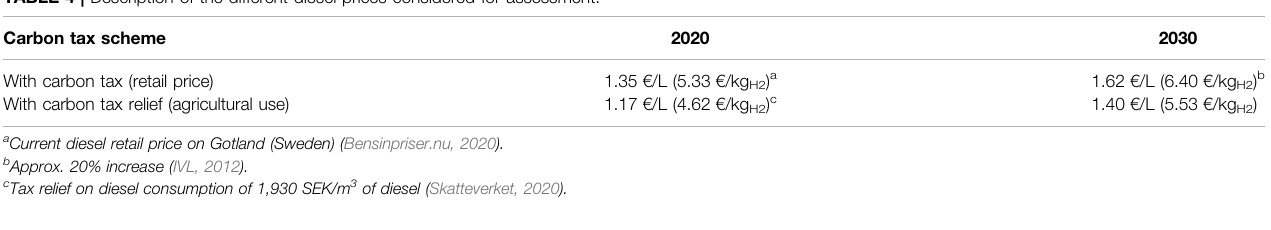
TABLE 4 | Description of the different diesel prices considered for